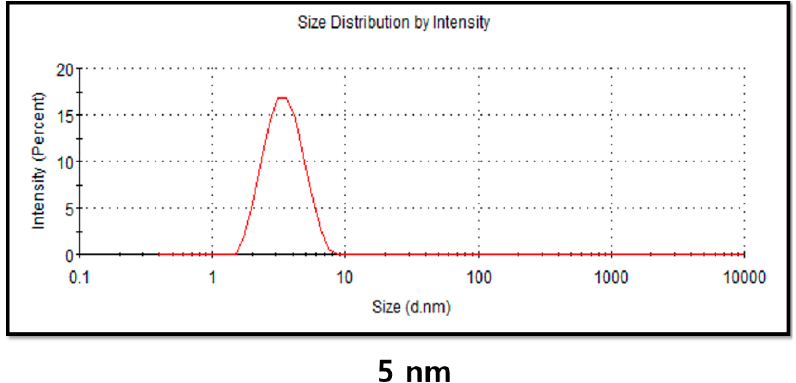
Figure 4. Determination of size distribution of palladium nanoparticles (PdNPs) using dynamic light scattering (DLS).